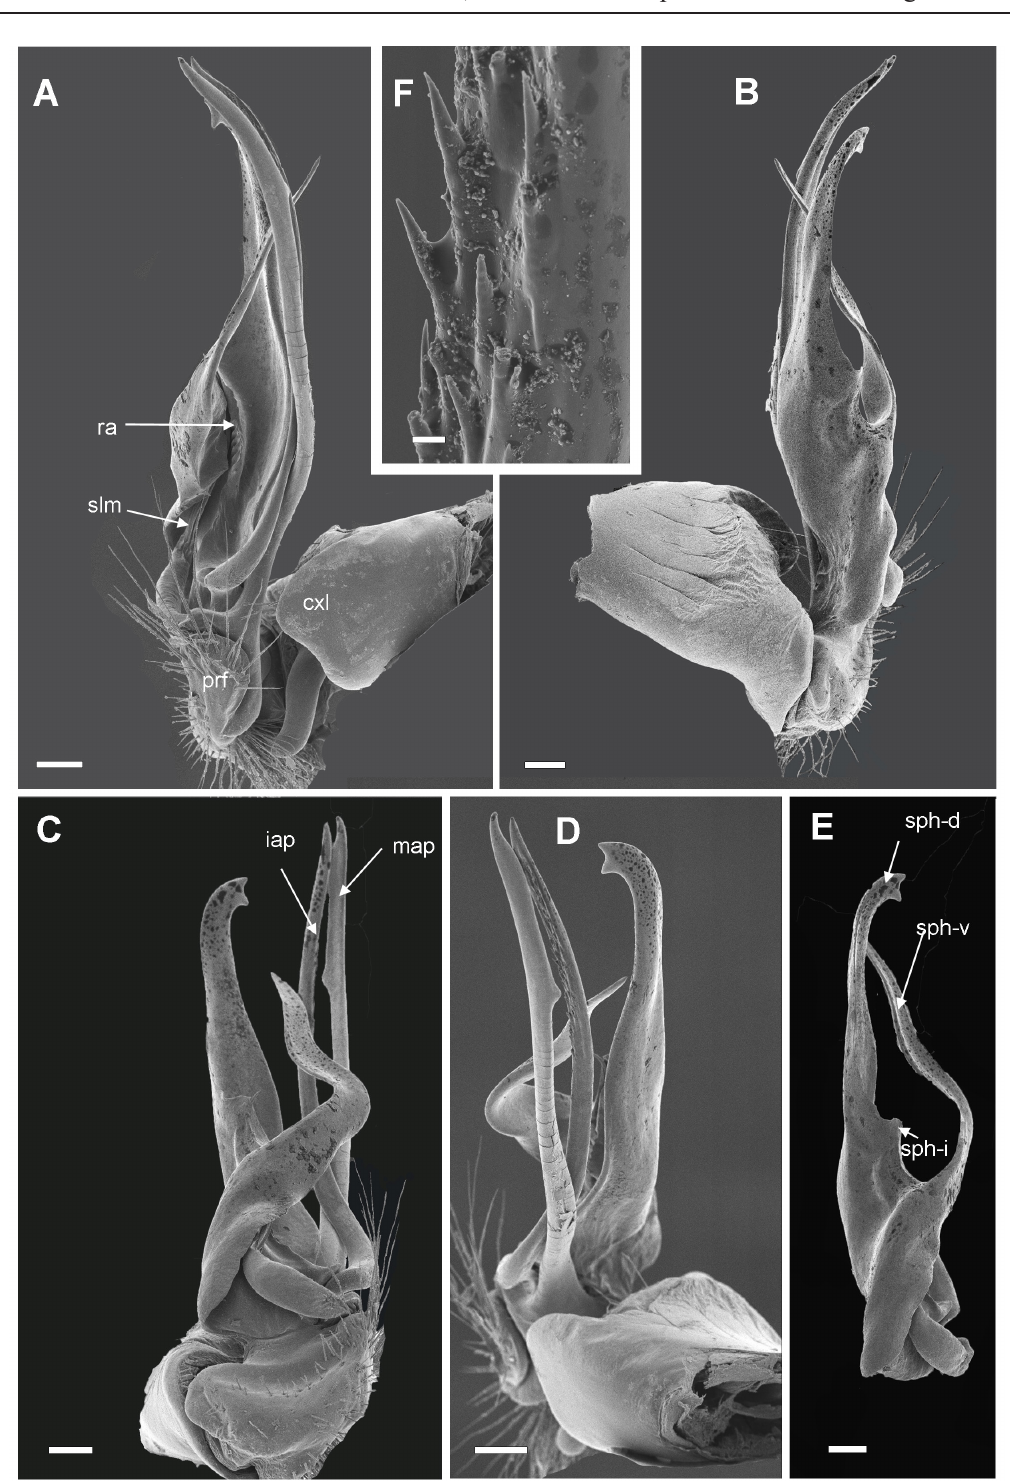
Fig. 19. Eviulisoma nessiteras sp. nov., paratypes from Udzungwa Scarp Catchment FR, right gonopod. A . Mesal view. B . Lateral view. C . Ventral view. D . Dorsal view. E . Solenophore, latero-ventral view. F . Spiny surface of iap. Abbreviations: cxl = coxal lobe; iap = intermediate acropodital process; map = mesal acropodital process; prf = prefemoral part; ra = ridged area of solenophore; slm = solenomere; sph-d , sph-i , sph-v = dorsal, intermediate and ventral lobes of solenophore. Scale bars: A–E = 0.1 mm; F = 0.005